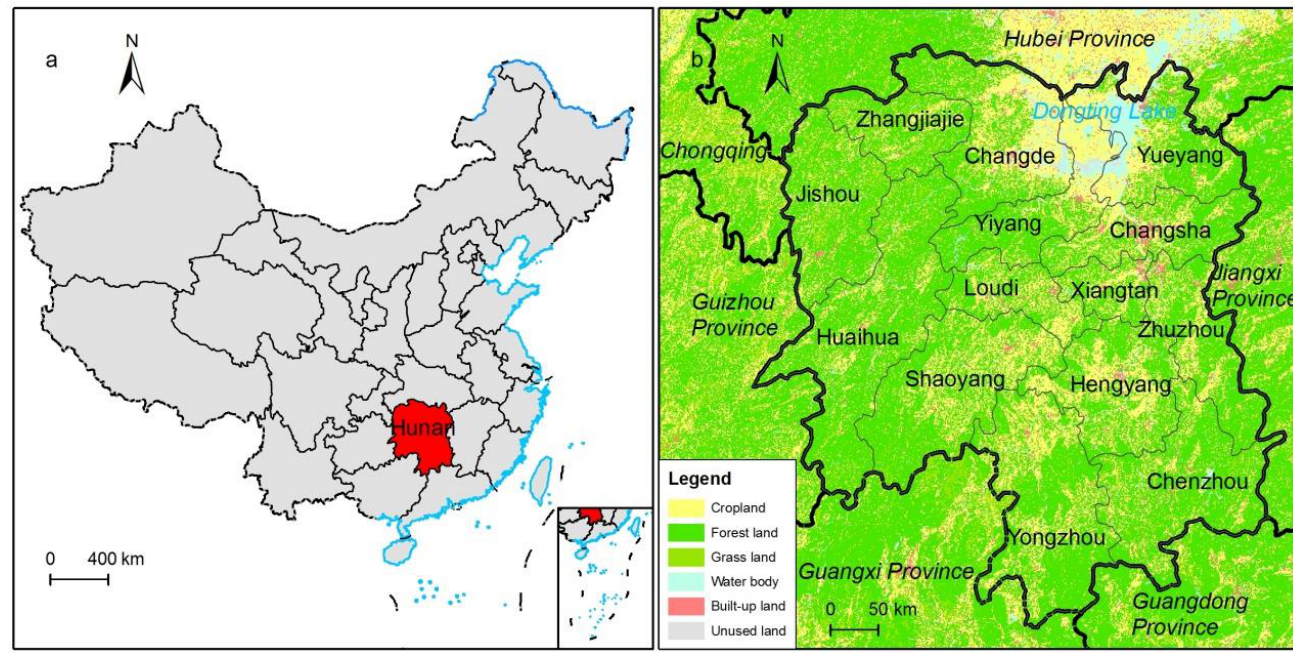
Figure 1. The location map ( a ) and the land cover distribution ( b ) of Hunan Province.